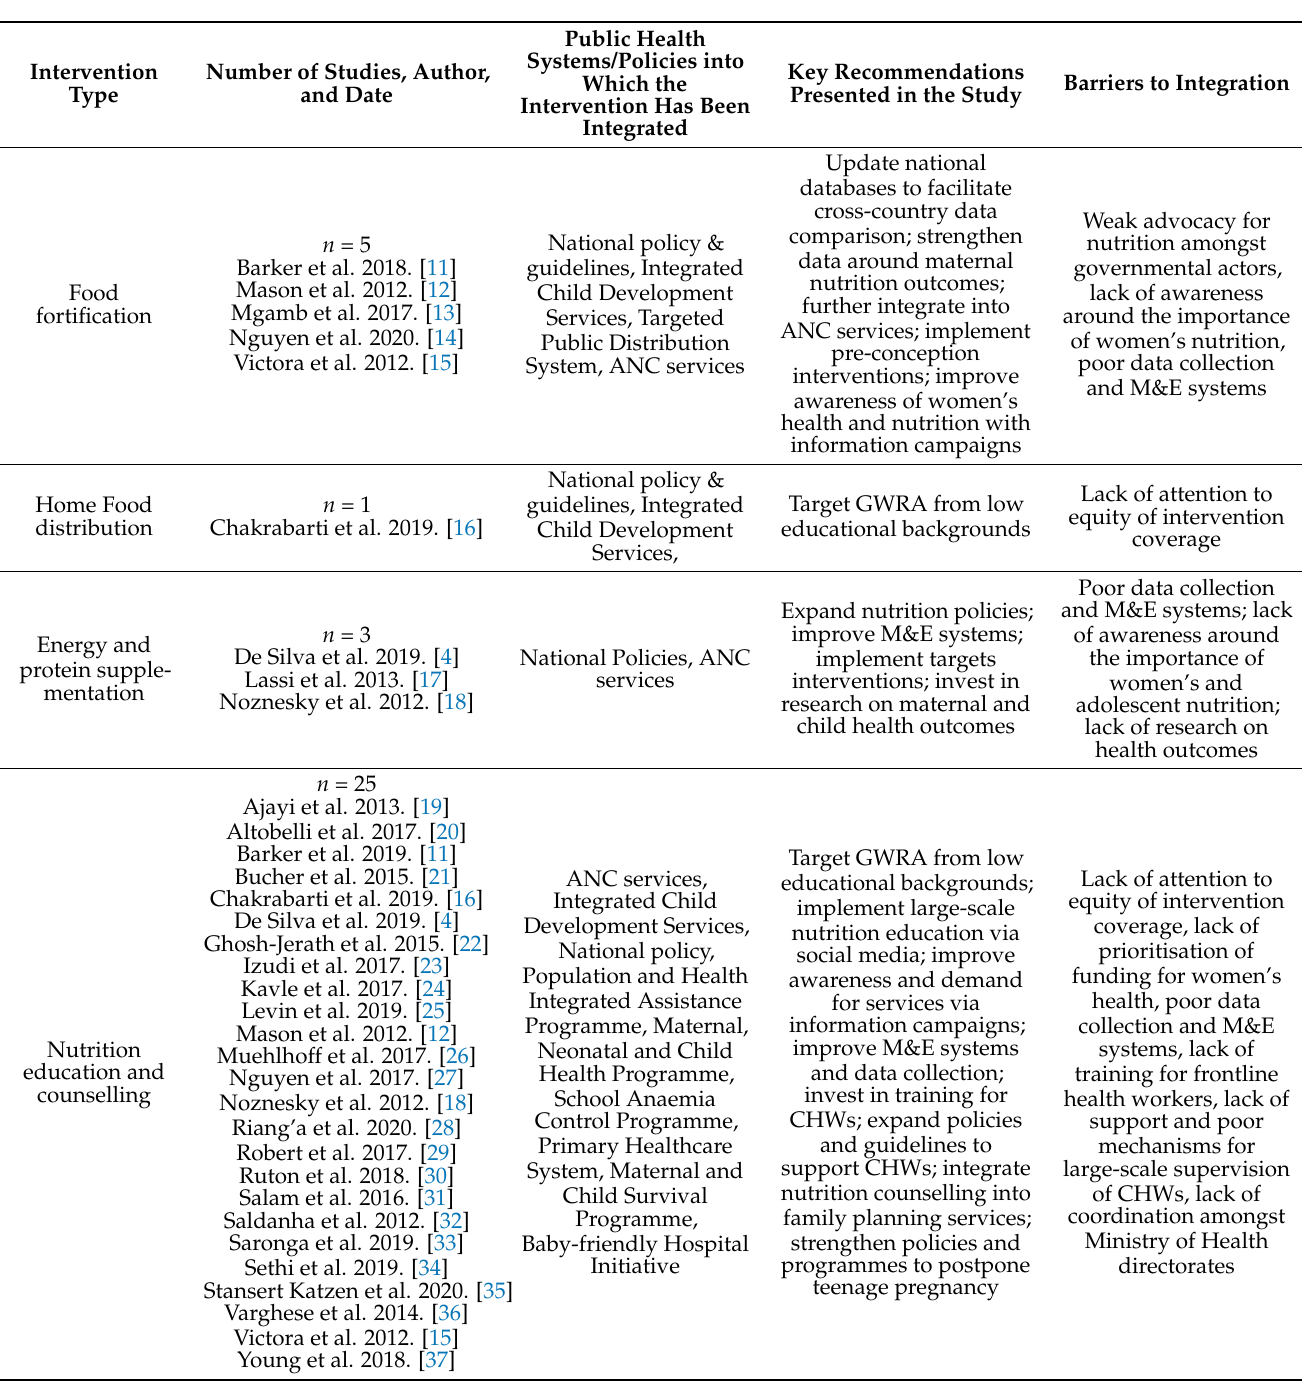
Table 1. Summary of literature findings by nutrition intervention